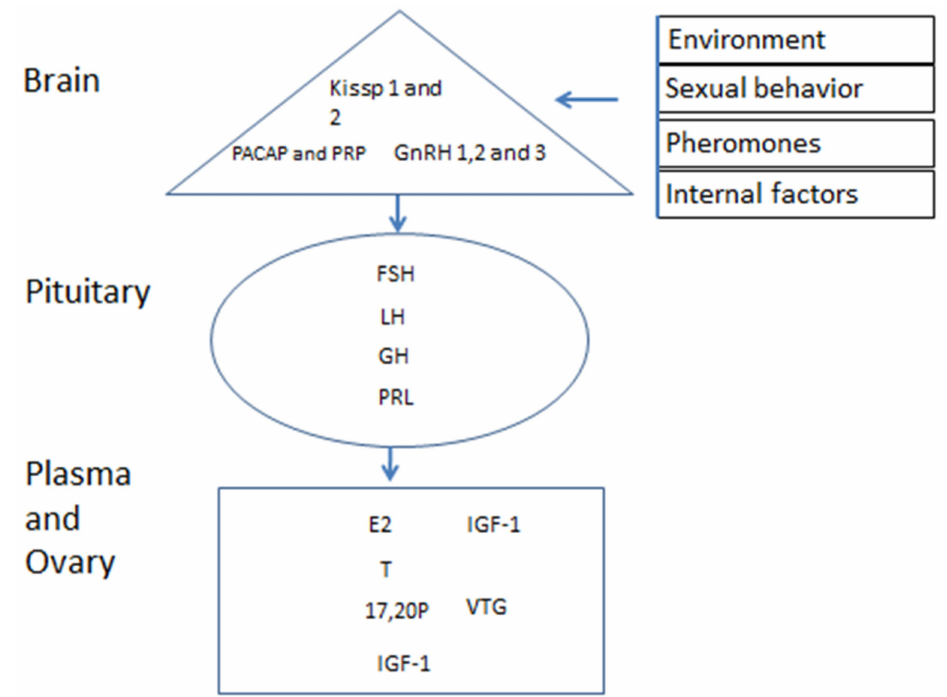
Figure 2. Factors a ff ecting the hormones of female reproduction. The environments [19,32], sexual behavior [11] and pheromones [12], Kisspeptin (Kiss 1 and 2) [18], gonadotropin-releasing hormone (GnRH1 and 3) [20], follicle-stimulating hormone (FSH), luteinizing hormone (LH) [39,42], pituitary adenylate cyclase-activating polypeptide (PACAP) and its related peptide (PRP) [20], growth hormone (GH) [50], prolactin (PRL) [35]. The FSH and LH act on the ovary to synthesize steroids, 17 β -estradiol (E2) [51,52], testosterone (T) [51,52], and 17 α ,20 β - dihydroxy-4-pregnen-3-one (17,20P) [51,52], and